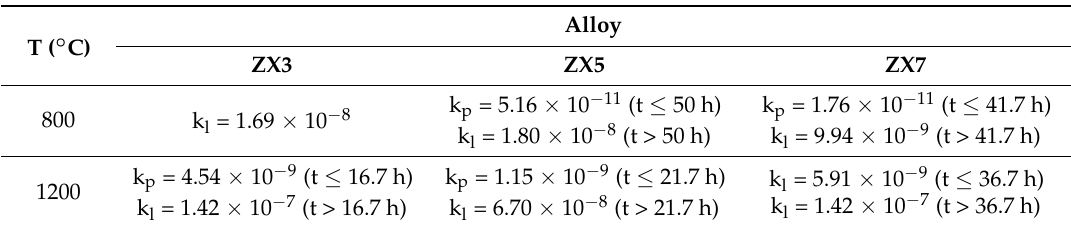
Table 2. The linear k l (g cm − 2 s − 1 ) and parabolic k p (g 2 cm − 4 s − 1 ) oxidation kinetic rate constants of the alloys ZX3, ZX5, and ZX7 for isothermal oxidation at 800 and 1200 ◦